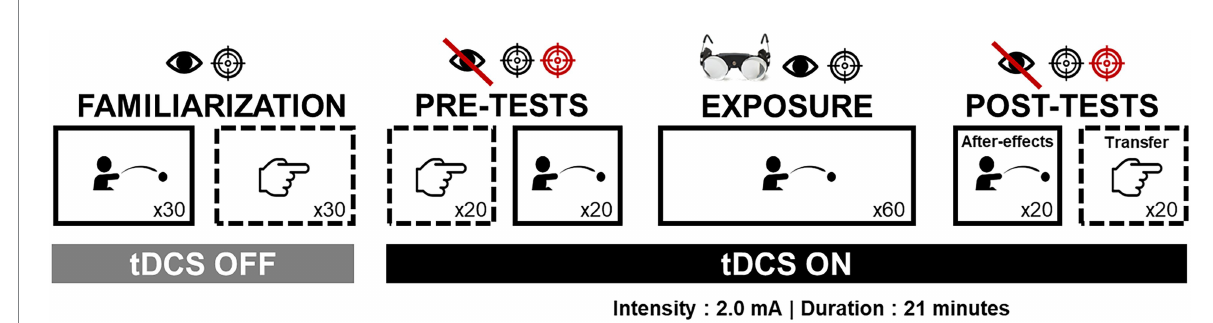
FIGURE 1 Experimental procedure. The figure depicts the different steps of the study and the conditions within each step, i.e., the task performed (throwing or pointing), visual feedback availability (bared eye or normal eye), trials number (i.e., 20, 30, or 60), the presence of prism goggles, targets number and color (one black target, or two targets—black and red), and tDCS conditions (Off or On). Solid boxes refer to the exposed task condition (i.e., throwing) while dotted boxes refer to the unexposed task condition (i.e.,